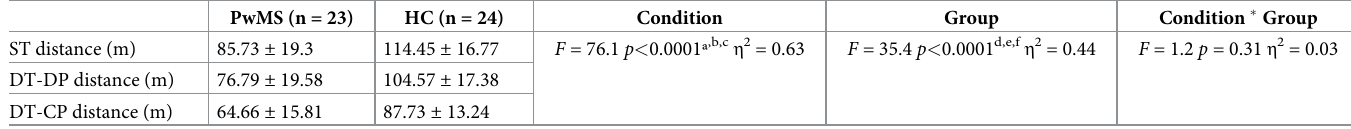
Table 3. Intragroup and between-group comparisons of direct scores of motor performance during DT and ST in pwMS and HC (mean ± SD).